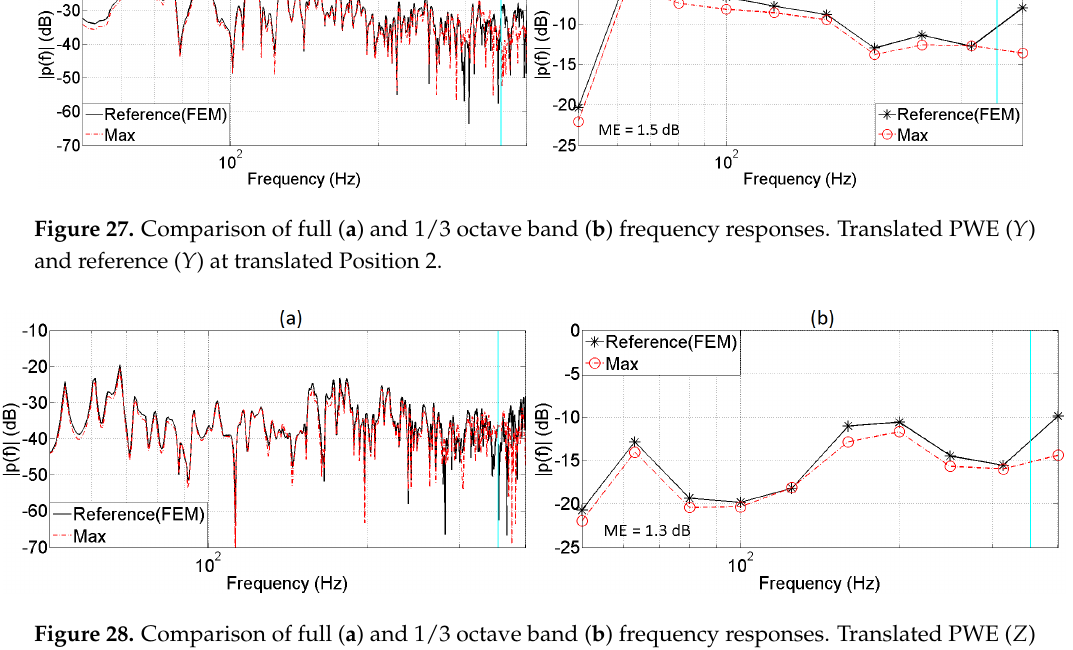
Figure 28. Comparison of full ( a ) and 1/3 octave band ( b ) frequency responses. Translated PWE ( Z ) and reference ( Z ) at translated Position 2.